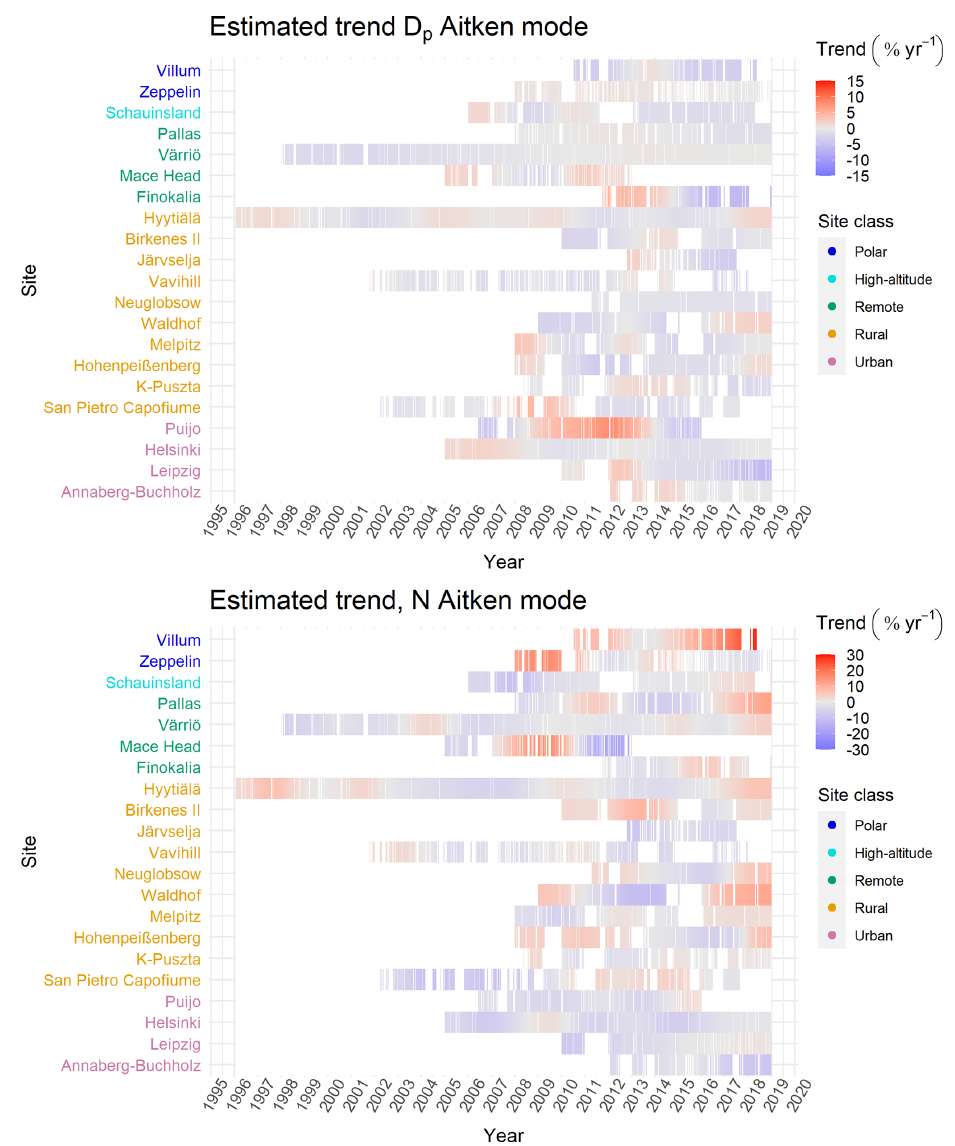
Figure 3. Estimated trends for Aitken mode D p and N at measurement sites. Trend has been calculated by DLM; see Sect. 2.3.1 for details. The overall trend presented in the figure is comparable with the long-term trend estimates given in Sect. 3.1. To get a DLM trend for 1 year, the 1d trend given by the model was multiplied by the number of days in a year (365 used for all years) and divided by the mean of the variable over the first observed year. For example, if the trend shows an increase of 10%yr − 1 it means that if the short-term increase would continue for a year, the concentration would be increased by 10% during the year compared to the first-year